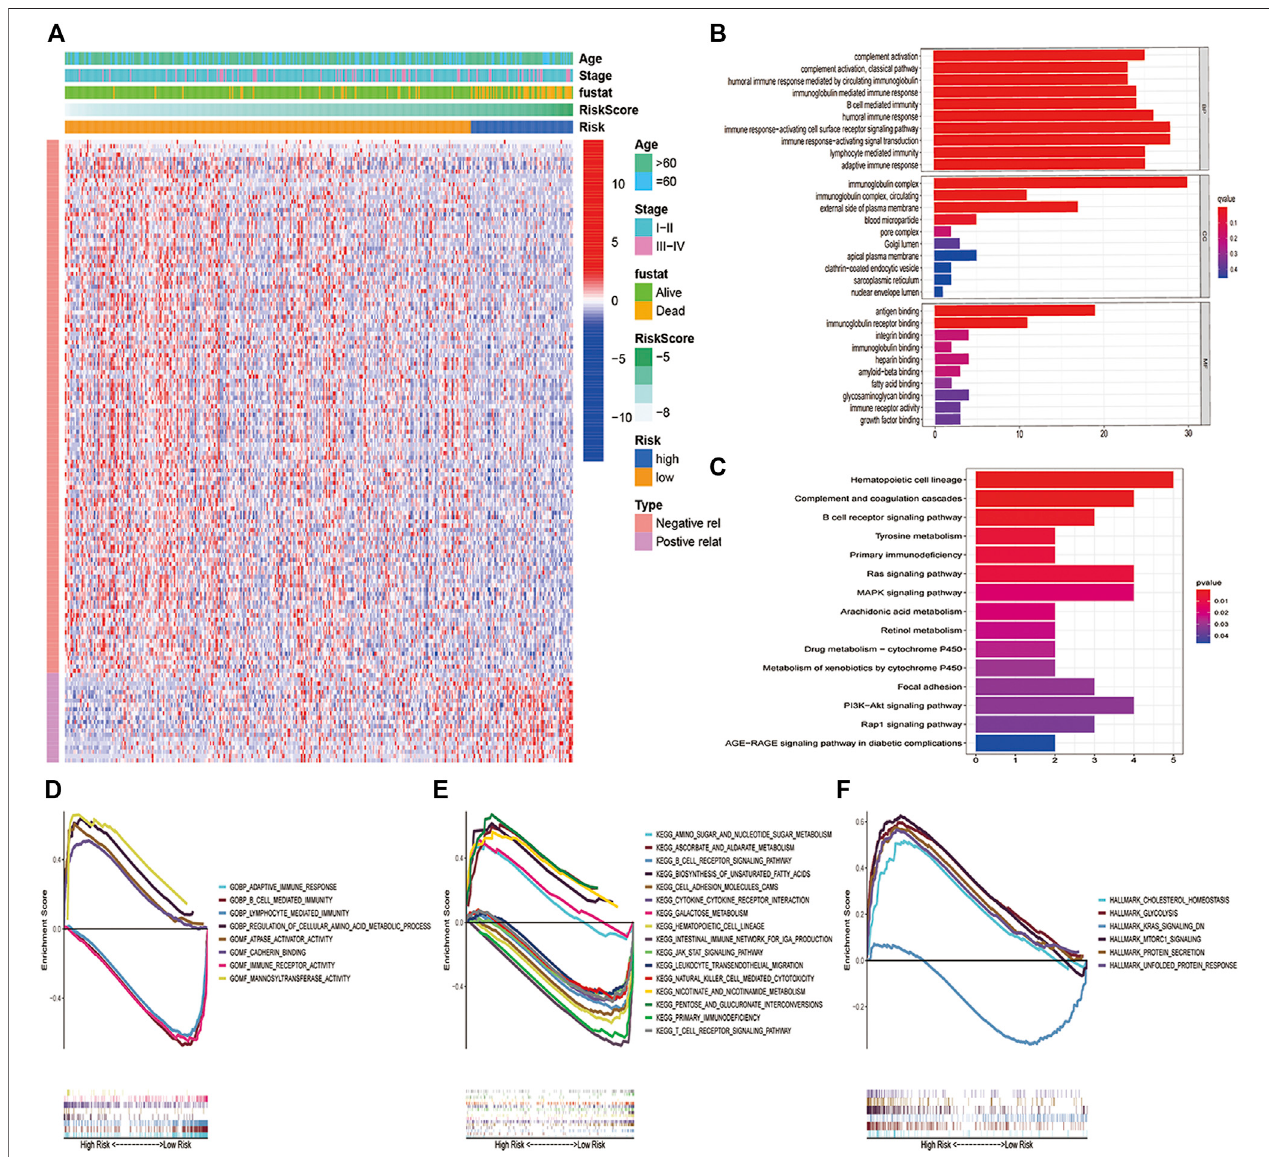
FIGURE4| Biological pathway and function between the two risk groups. (A) Heatmap and the difference of clinical characteristics and DEGs between the high- and low-risk groups (blue: low expression level; red: high expression level). (B) GO and (C) KEGG analysis revealed that DEGs in high- and low-risk subgroups were enriched in multiple immune and tumor-related pathways. (D – F) GSEA analysis validated multiple biological pathways related to inmmunity and tumor enriched in the high-risk group and low-risk group.